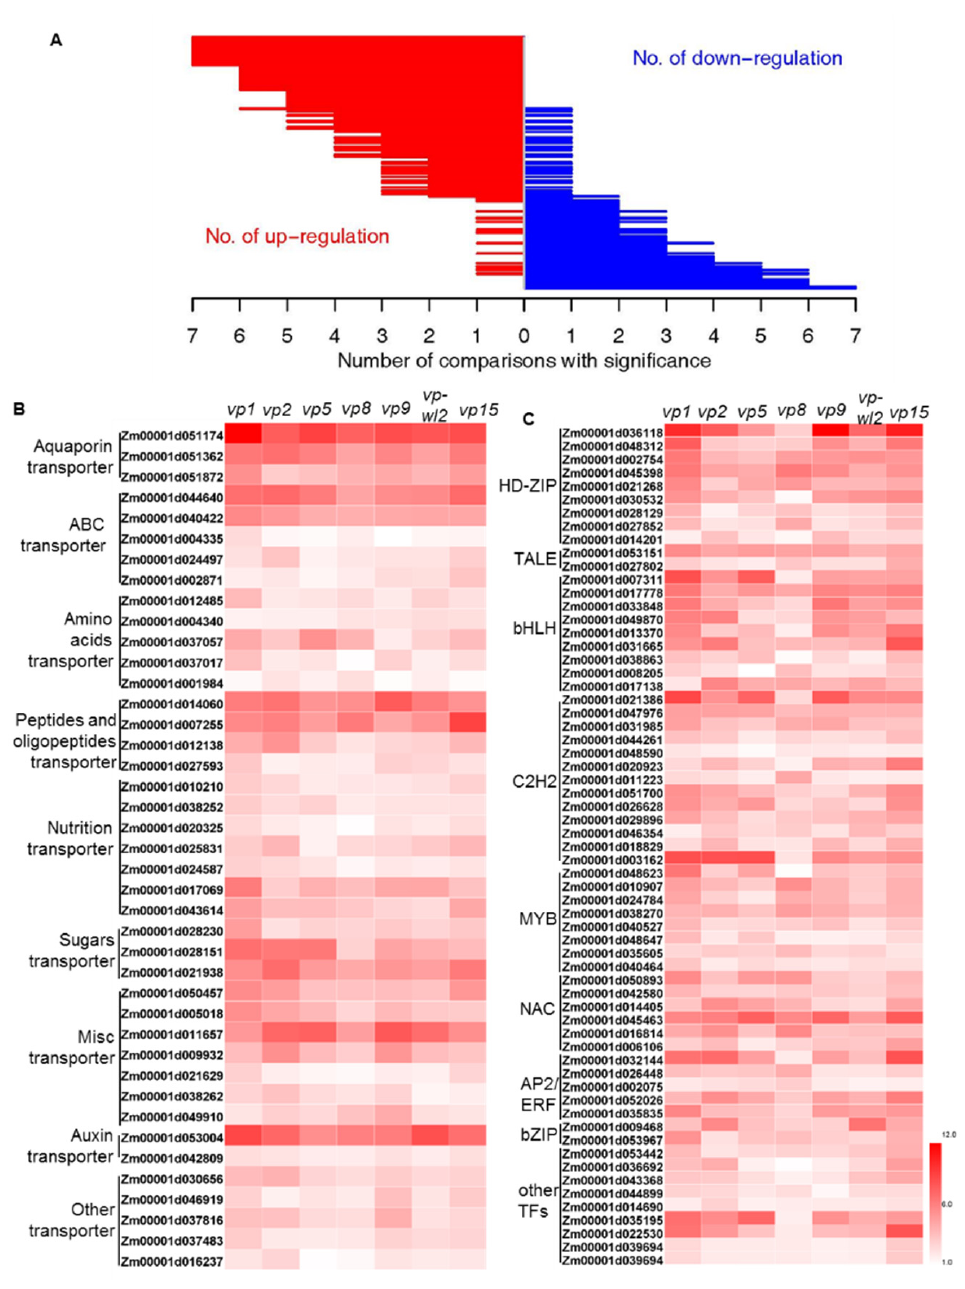
Figure 3. Differentially expression genes (DEGs) between mutants and wild-types of seven vivipary mutants. ( A ) Genes were upregulated or downregulated in the seven comparisons of vivipary mutants versus wild-types. The level of upregulation (red) and downregulation (blue) genes in the vivipary mutants was determined and plotted. The X -axis represents the number of comparisons, and the Y-scale represents the level of genes. From top to bottom, the number of upregulated and downregulated genes was used to facilitate sorting. ( B , C ) Heatmap analysis of transporters ( B ) and TFs ( C ) showing upregulation in seven vivipary mutants. The DEGs were obtained by comparing the mutant to WT (|log 2 fold change| ≥ 1 and FDR < 0.05).